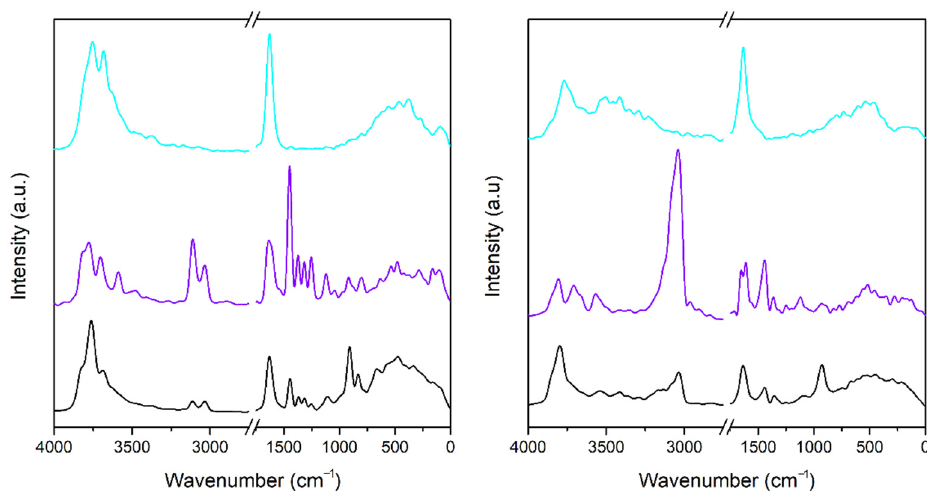
Figure 10. The calculated total VDOS (black) of A-Mt (left) and A-Bd (right), the calculated VDOS of the atrazine molecule (violet) and the calculated VDOS of water molecules in the interlayer (cyan).